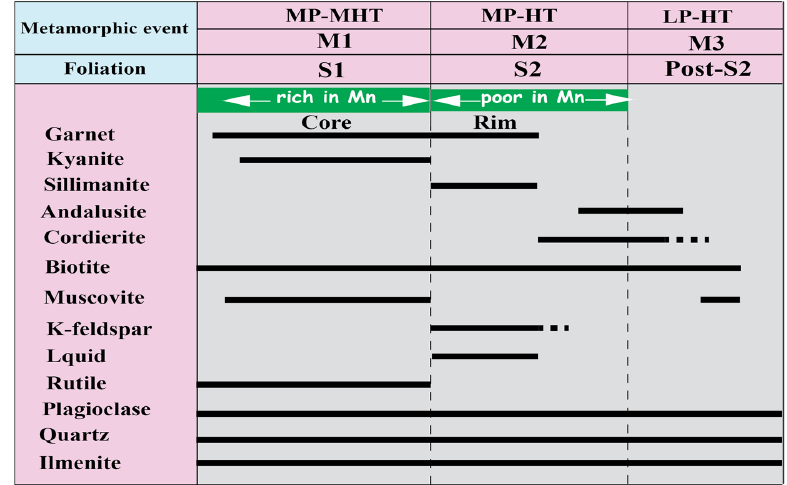
Figure 5. Temporal relationship between metamorphism and deformation in the migmatitic paragneisses of the Filali unit. The figure also shows the main mineralogical assemblages representative of both S1 and S2 schistosities in this rock.